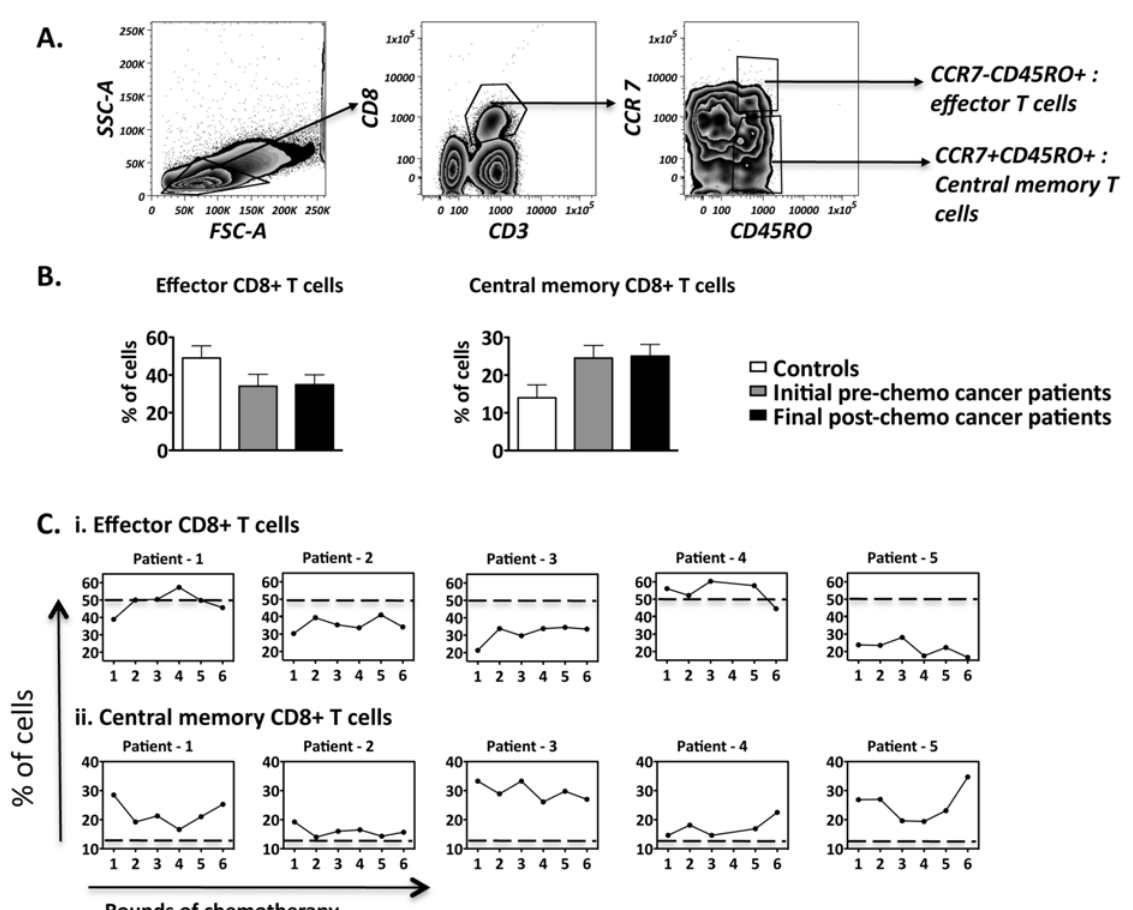
organ-homing surface molecule CCR7 expressed on central memory T cells, yielding effector (CCR7 − CD45RO+) and central memory (CCR7+CD45RO+) CD8+ T cells for analysis (Figure 2A). Figure 2. Frequencies of CD8+ T cell subsets present within the peripheral blood of ovarian cancer patients over the course of chemotherapy. Flow cytometry was performed on PBMCS isolated from patients (n = 5) and controls (n = 6). ( A ) The gating strategy employed to identify effector and central memory CD8+ T cells; ( B ) Comparison of the CD8+ T cell subset frequencies between controls and patients; pre-chemo representing 0 rounds while post-chemo represents 6 rounds of chemotherapy; ( C ) Frequency fluctuations of CD8+ T cell subsets of patients over the course of chemotherapy. The dotted line represents the mean frequency of the healthy controls. Comparison of CD8+ T cell subset frequencies between controls and patients: not